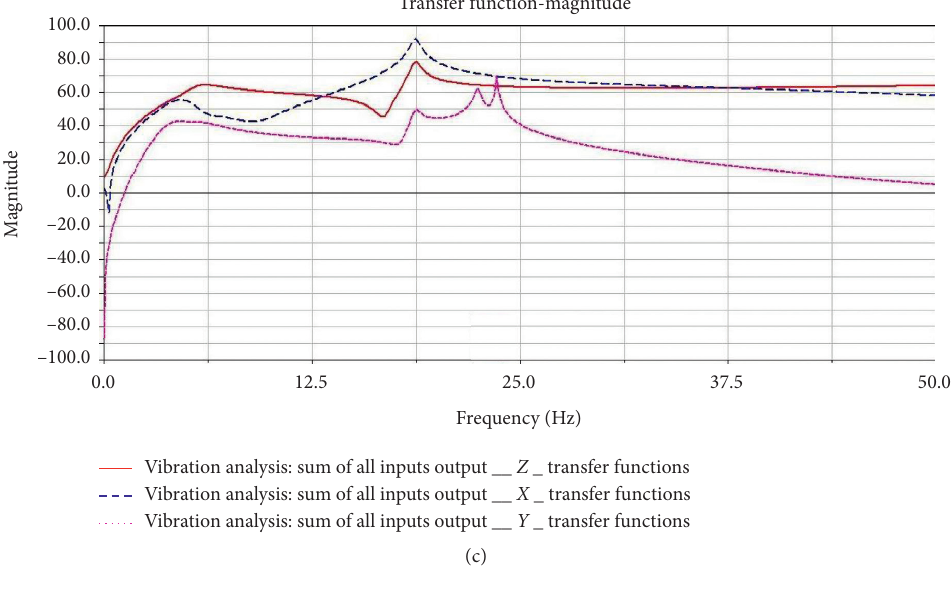
Figure 7: Diagram transfer function diagram under different working conditions. (a) Vibration transfer function diagram under the vertical working condition. (b) Diagram of Vibration transfer function under the back-jump working condition. (c) Vibration transfer function diagram under forward-jump condition.